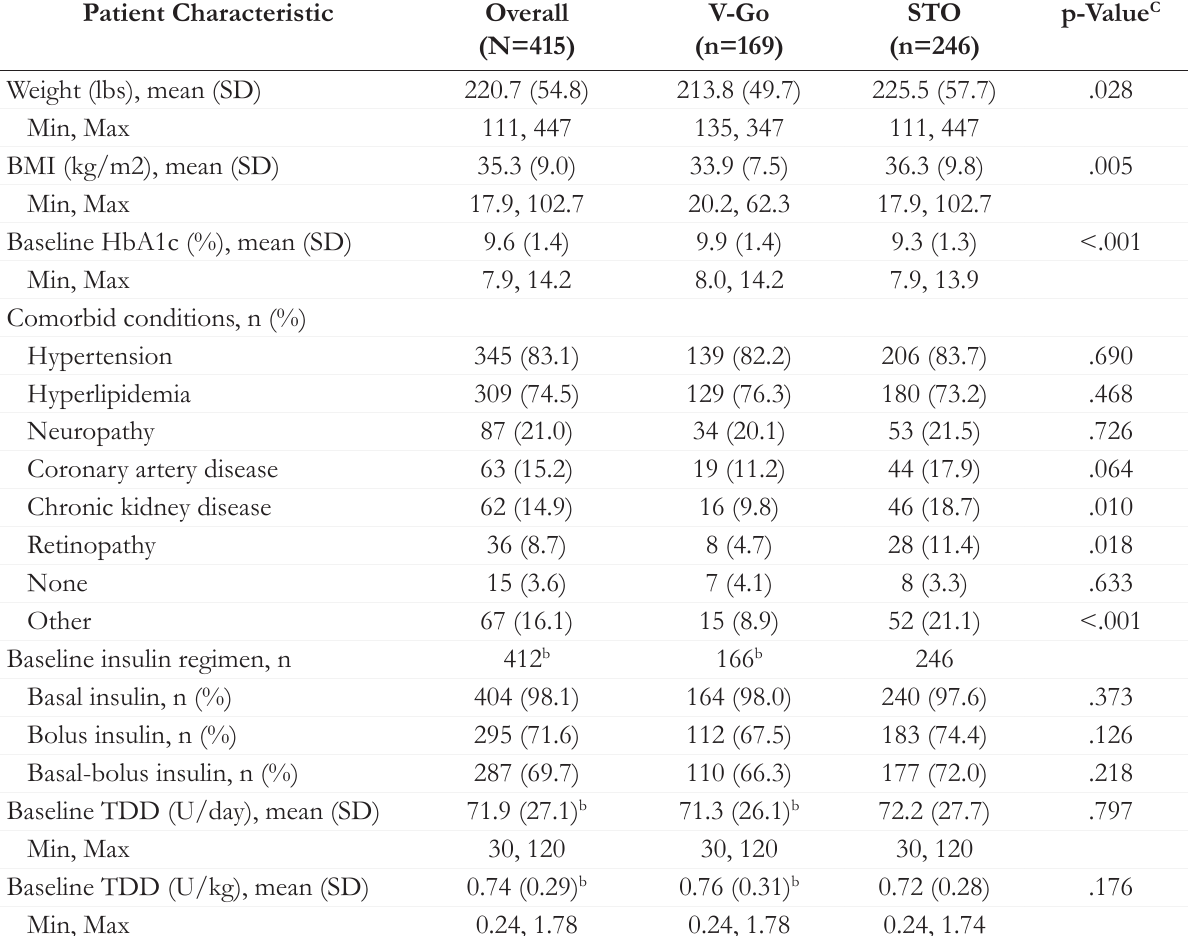
Table 1. Patient Demographic and Baseline Characteristics (Analysis Population), Continued Patient